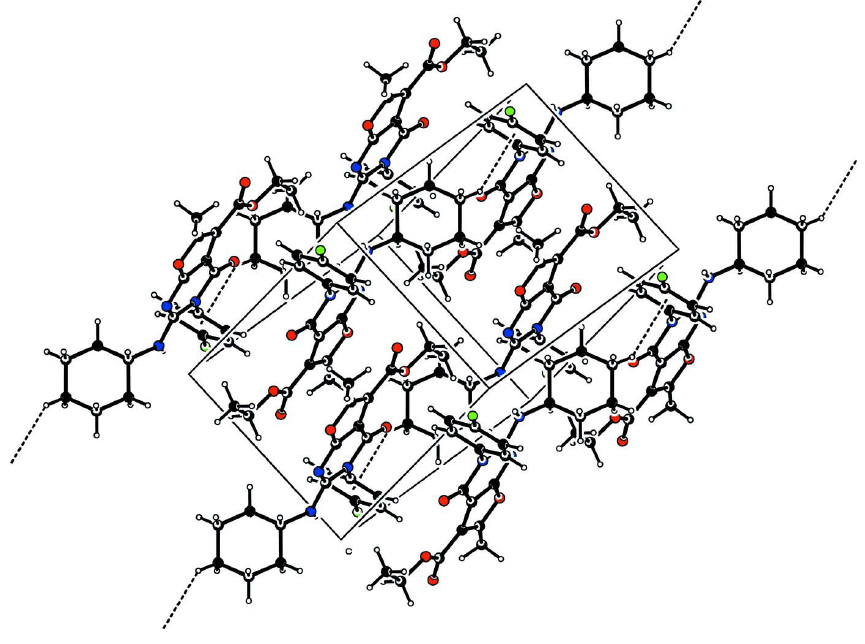
Figure 1 The molecular structure of the title compound (I), showing the atom-labeling scheme. Displacement ellipsoids are drawn at the 50% probability level. Only the intramolecular C—H···O and C—H···N hydrogen bonds is shown as dashed